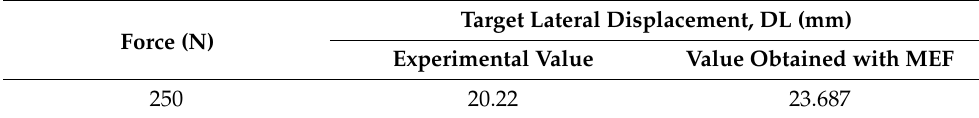
Table 5. Comparison of experimental results with results obtained by MEF for CA500,